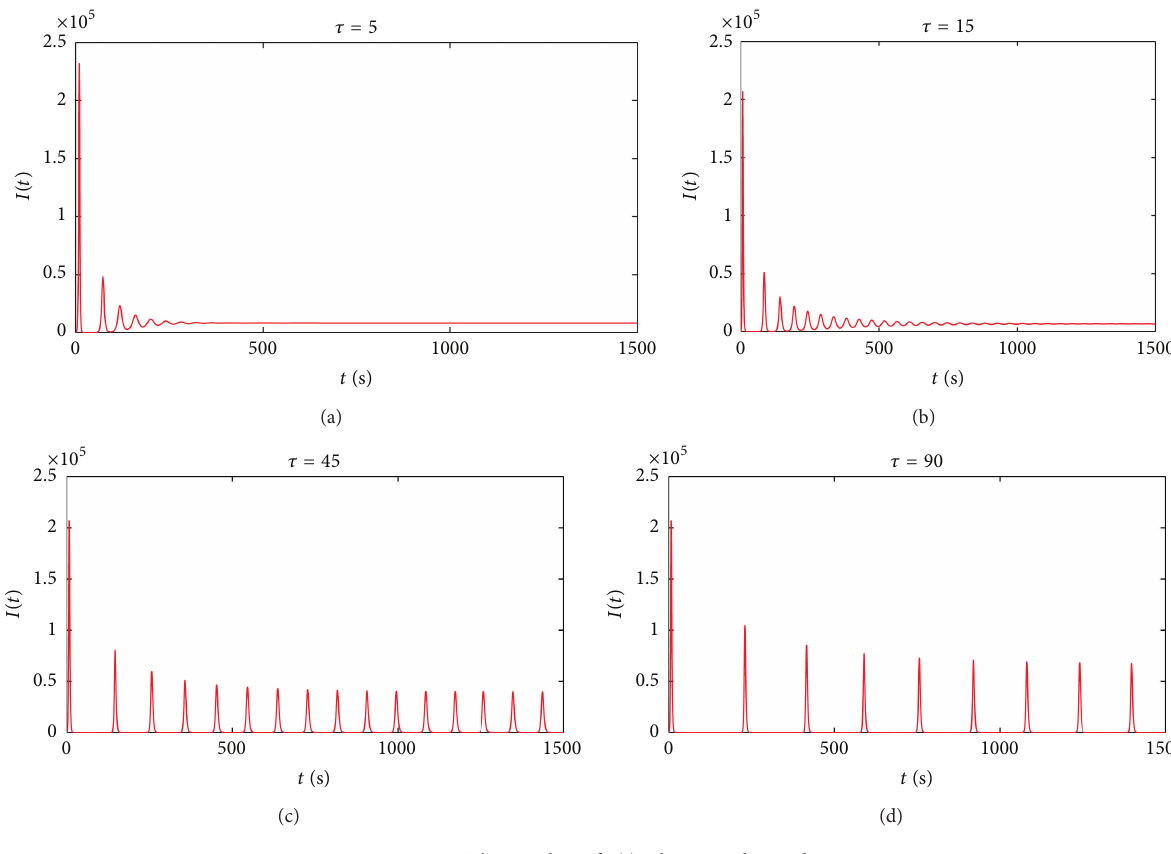
Figure 7: The number of 𝐼(𝑡) when 𝜏 is